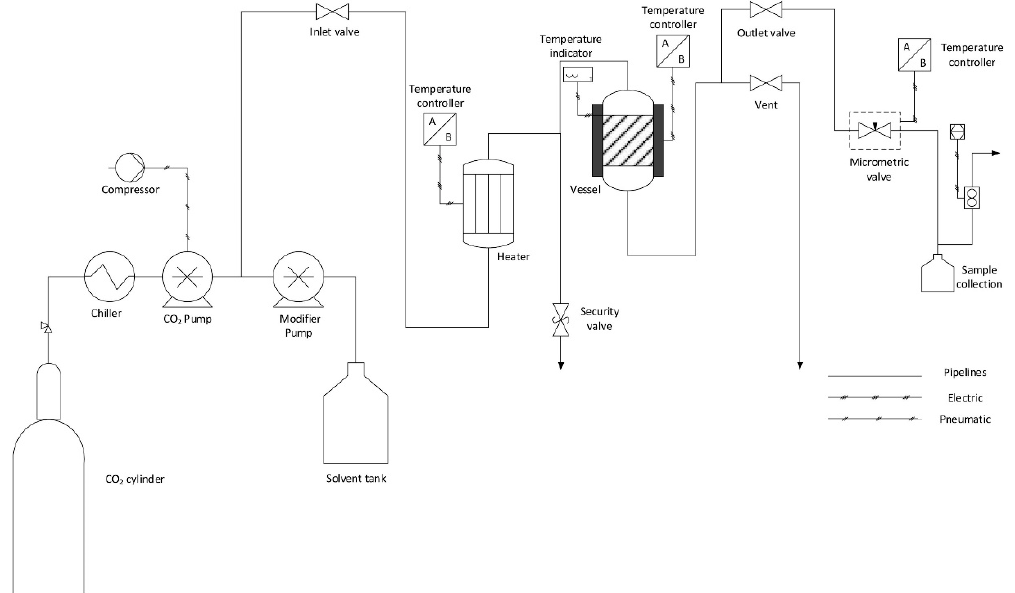
Figure 1. Diagram of the supercritical fluid extraction (SFE) equipment (Applied Separations, Speed, Allentown, PA, USA). The main parts are: CO 2 cylinder; CO 2 pump; compressor; modifier pump; solvent tank; inlet valve; heater; extraction vessel and oven vessel; micrometric valve; sample collection.